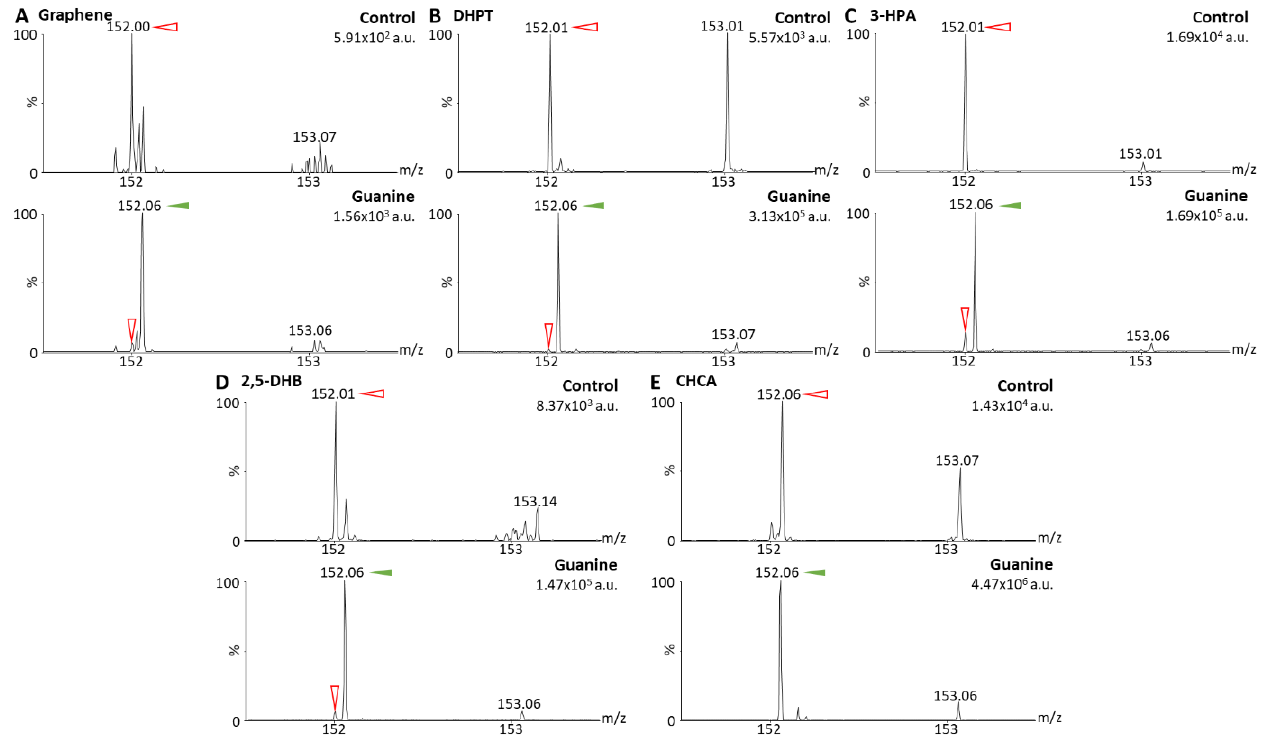
Figure 2. Matrix-assisted laser desorption/ionization (MALDI) mass spectra of solvent (control) and guanine solutions at 0.5 µg/mL in MeOH/H 2 O 1:1 obtained with graphene as MALDI matrix ( A ), 2,3,4,5-tetrakis( 3′ , 4′ -dihydroxylphenyl)thiophene (DHPT) ( B ), 3-hydroxypicolinic acid (3-HPA) ( C ), 2,5-dihydroxybenzoic acid (2,5-DHB) ( D ), and alpha-cyano-4-hydroxy-cinnamic acid (CHCA) ( E ). Spectra were acquired using method Q-152 (positive resolution mode, with quadrupole focused on m/z 152). Maximum intensities are given in arbitrary units (a.u.) on the top right corner of each spectrum. Peaks from the MALDI matrices are marked with red open arrows and peaks from guanine (m/z 152.06) with green solid arrows.